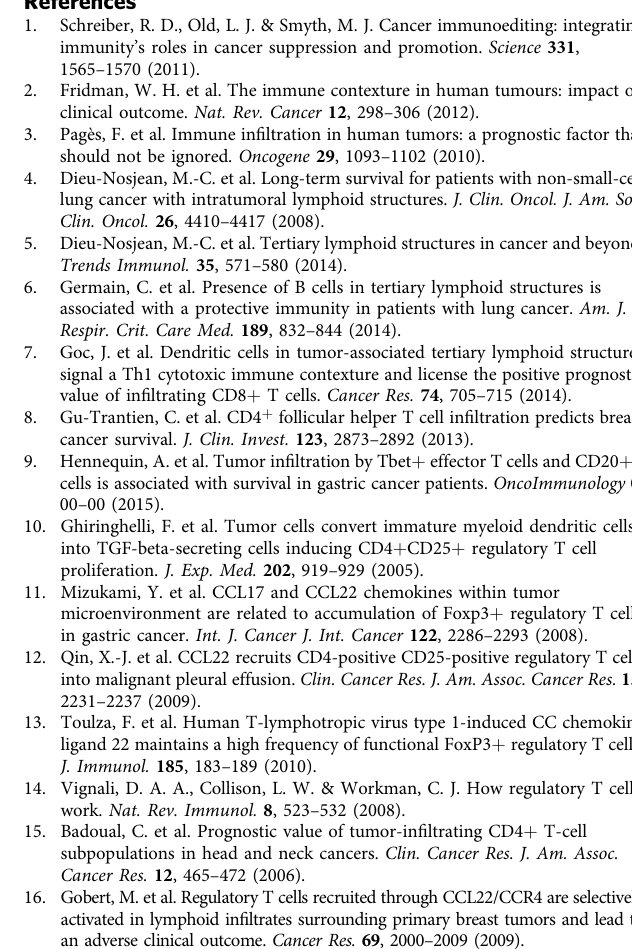
Supplementary Fig. 2. The optimal cut-off values are 21.93277 for CD3 + FoxP3 + Treg cells/mm 2 , 127.0348 for TLS CD3 + FoxP3 + Treg cells/mm 2 , 1021.976